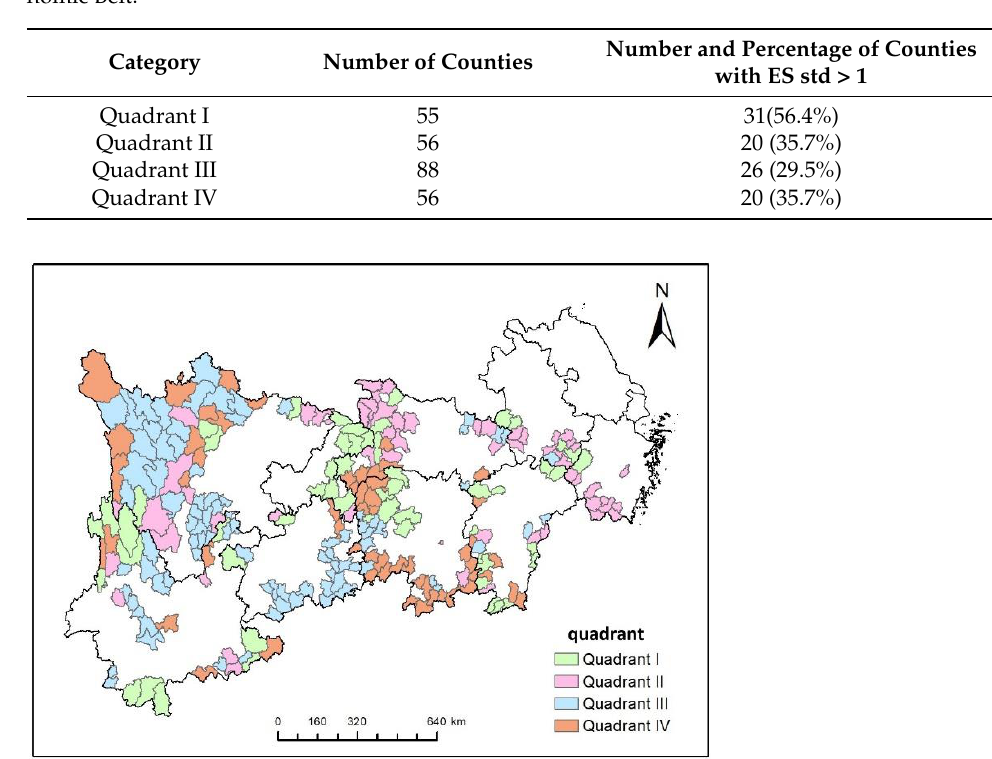
Table 5. Categorization of National Key Ecological Function Counties in the Yangtze River Eco- nomic Belt.